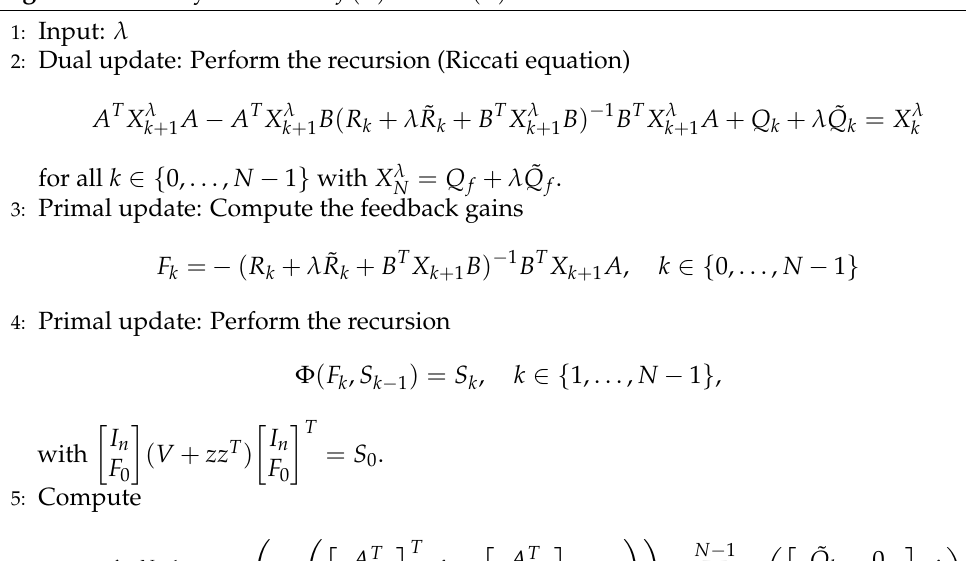
Algorithm 2 Policy evaluation f ( λ ) = Eval ( λ )